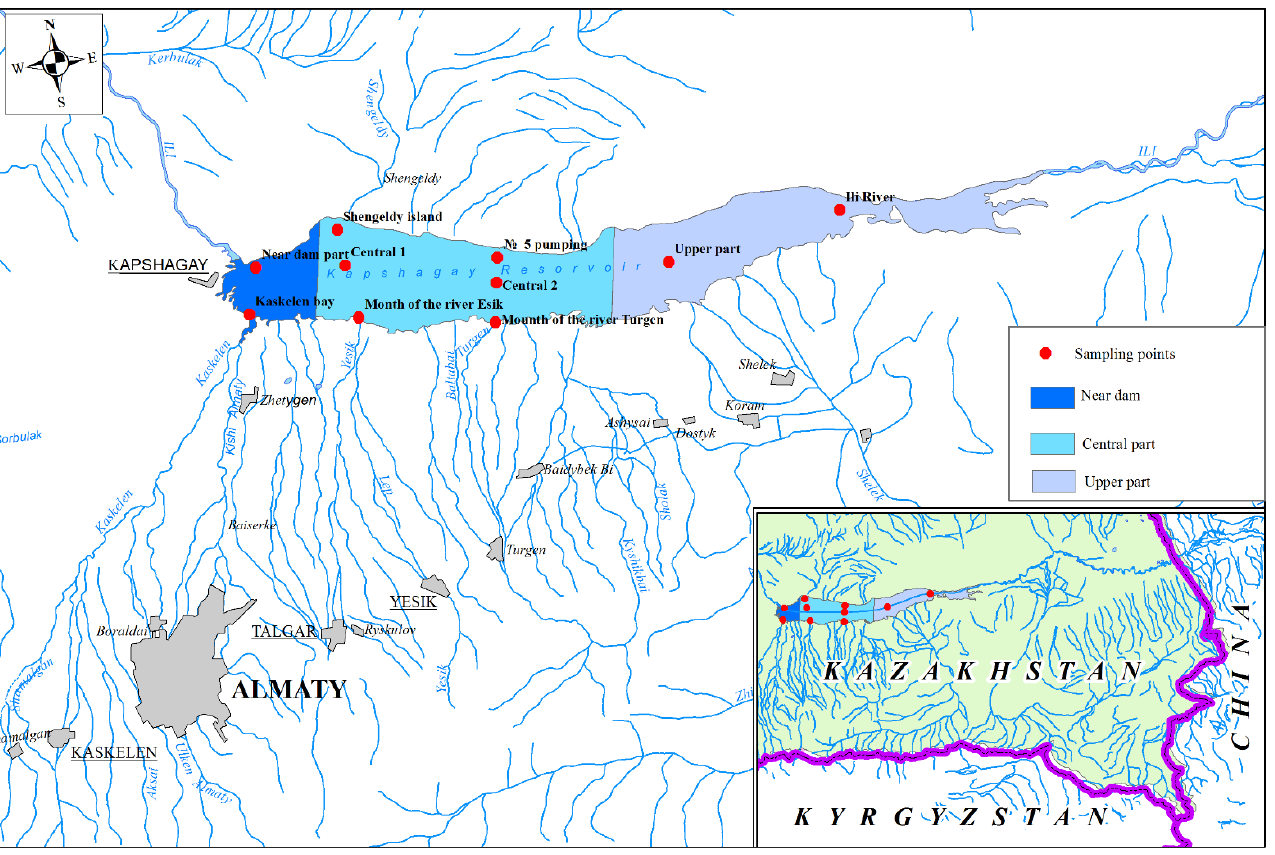
Figure 2. Scheme of the Kapshagay Reservoir with sampling points for bottom sediment in South-East Kazakhstan. (authors Ismukhanova L.T., Madibekov